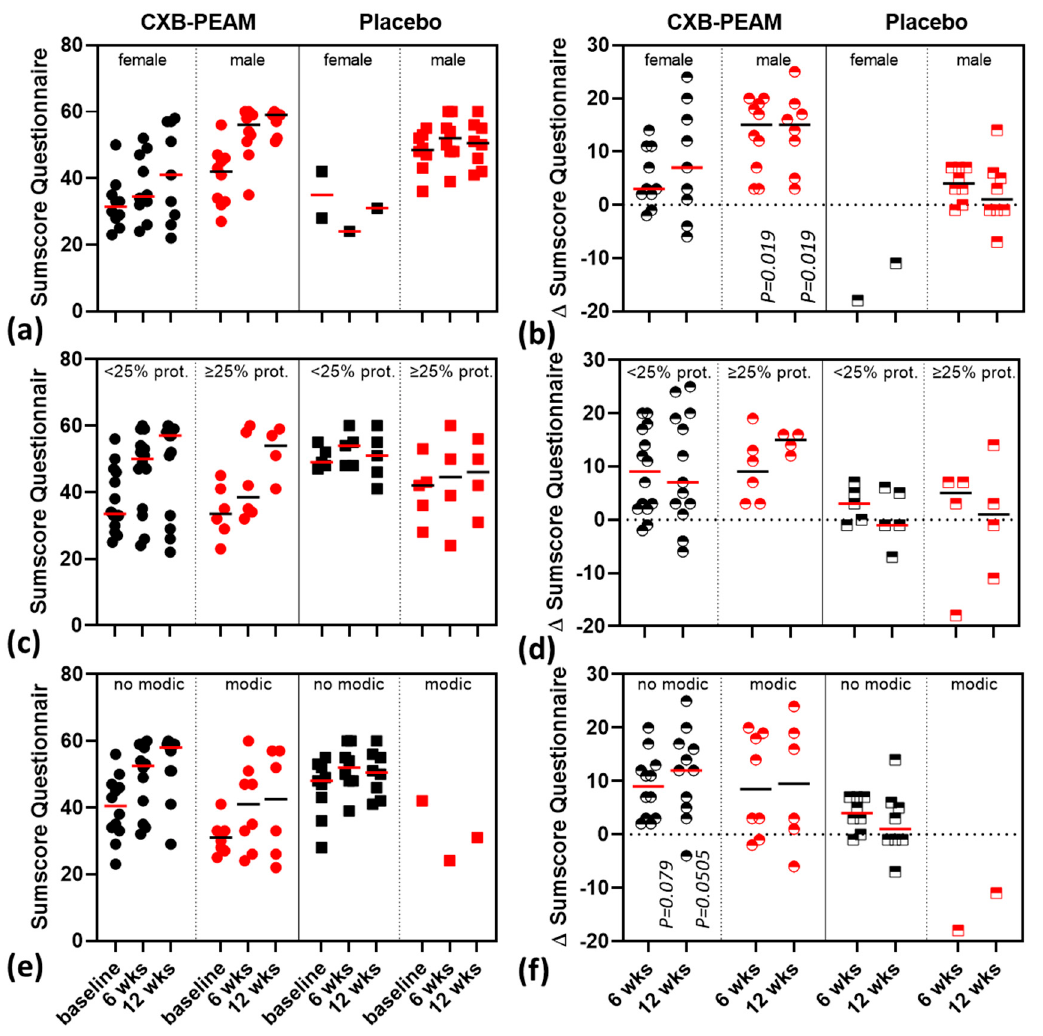
Figure 1. Subgroup scatterplots for questionnaire sumscore (median indicated) and corresponding change in time of the sumscore ( ∆ sumscore) (median indicated) in 30 dogs suffering from degenerative lumbosacral stenosis treated with intradiscal injection of celecoxib-polyesteramide microspheres (CXB-PEAMs) or unloaded PEAMs (placebo). ( a ) Sumscore and ( b ) ∆ sumscore for male/female demonstrating significant improvement over time within the male group of dogs with degenerative lumbosacral stenosis. ( c ) Sumscore and ( d ) ∆ sumscore for degree of disc protrusion (<25% and ≥ 25%) were not dependent on the degree of disc protrusion. ( e ) Sumscore and ( f ) ∆ sumscore Modic changes (no/yes) indicated that, within the subgroup of dogs with no Modic changes, the improvement over time tended to be significant at both time points.